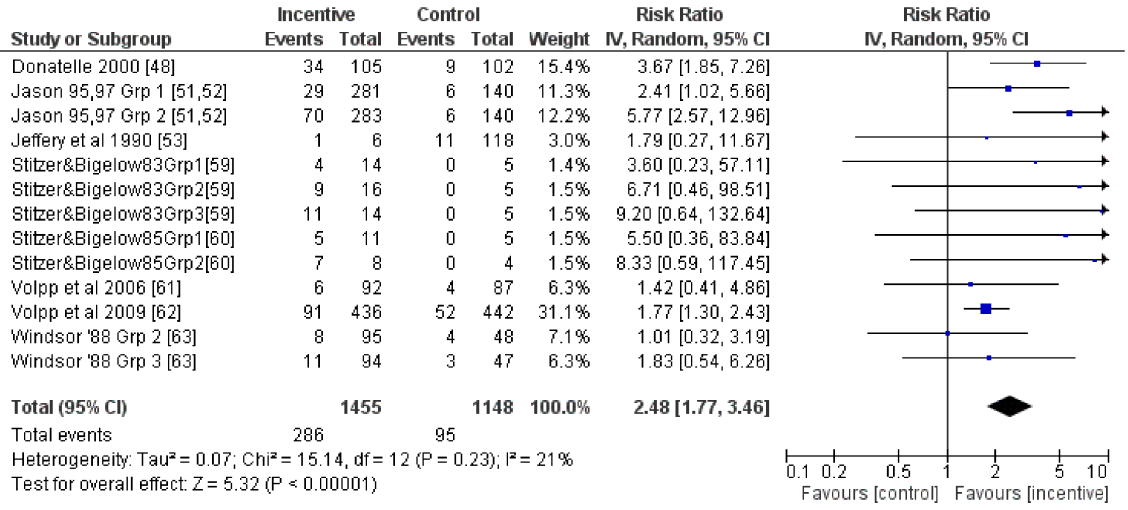
Figure 3. Meta-analysis of financial incentives for smoking cessation (follow-up # six months).